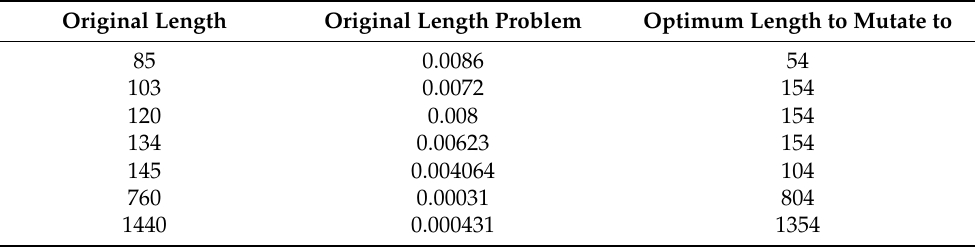
Table 5. Sample of length mapping of Skype App, using OPriv.